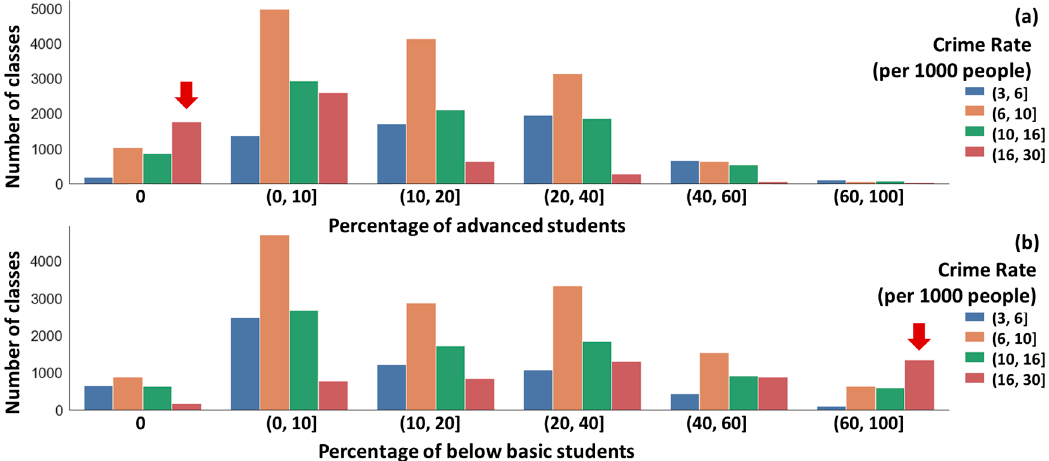
Figure 4. Analysis of the relationship between crime rate (per 1000 people) and academic performance; ( a ) percentage of advanced students; ( b ) percentage of below basic students. The red arrows indicate the highest crime rates, which are the groups specifically analyzed.